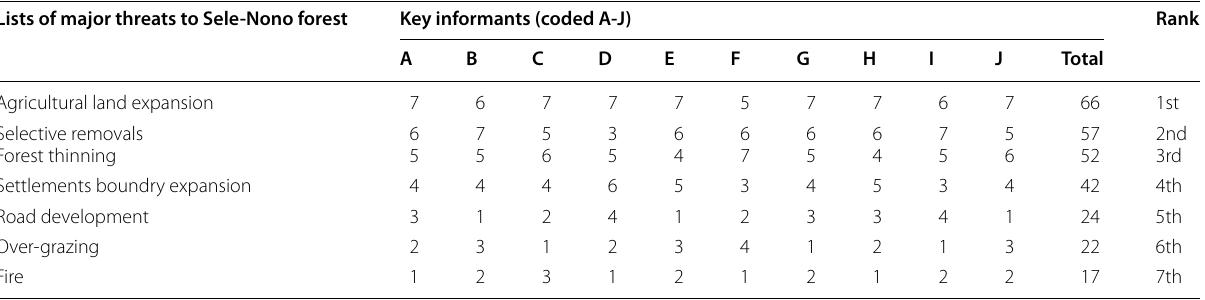
least damaging, 7 most damaging) = =